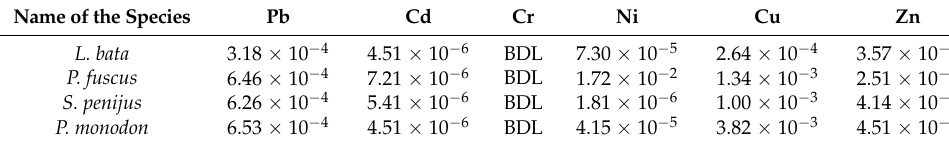
Table 3. EDI concentrations ( µ g/g/person) of fish and shrimp.